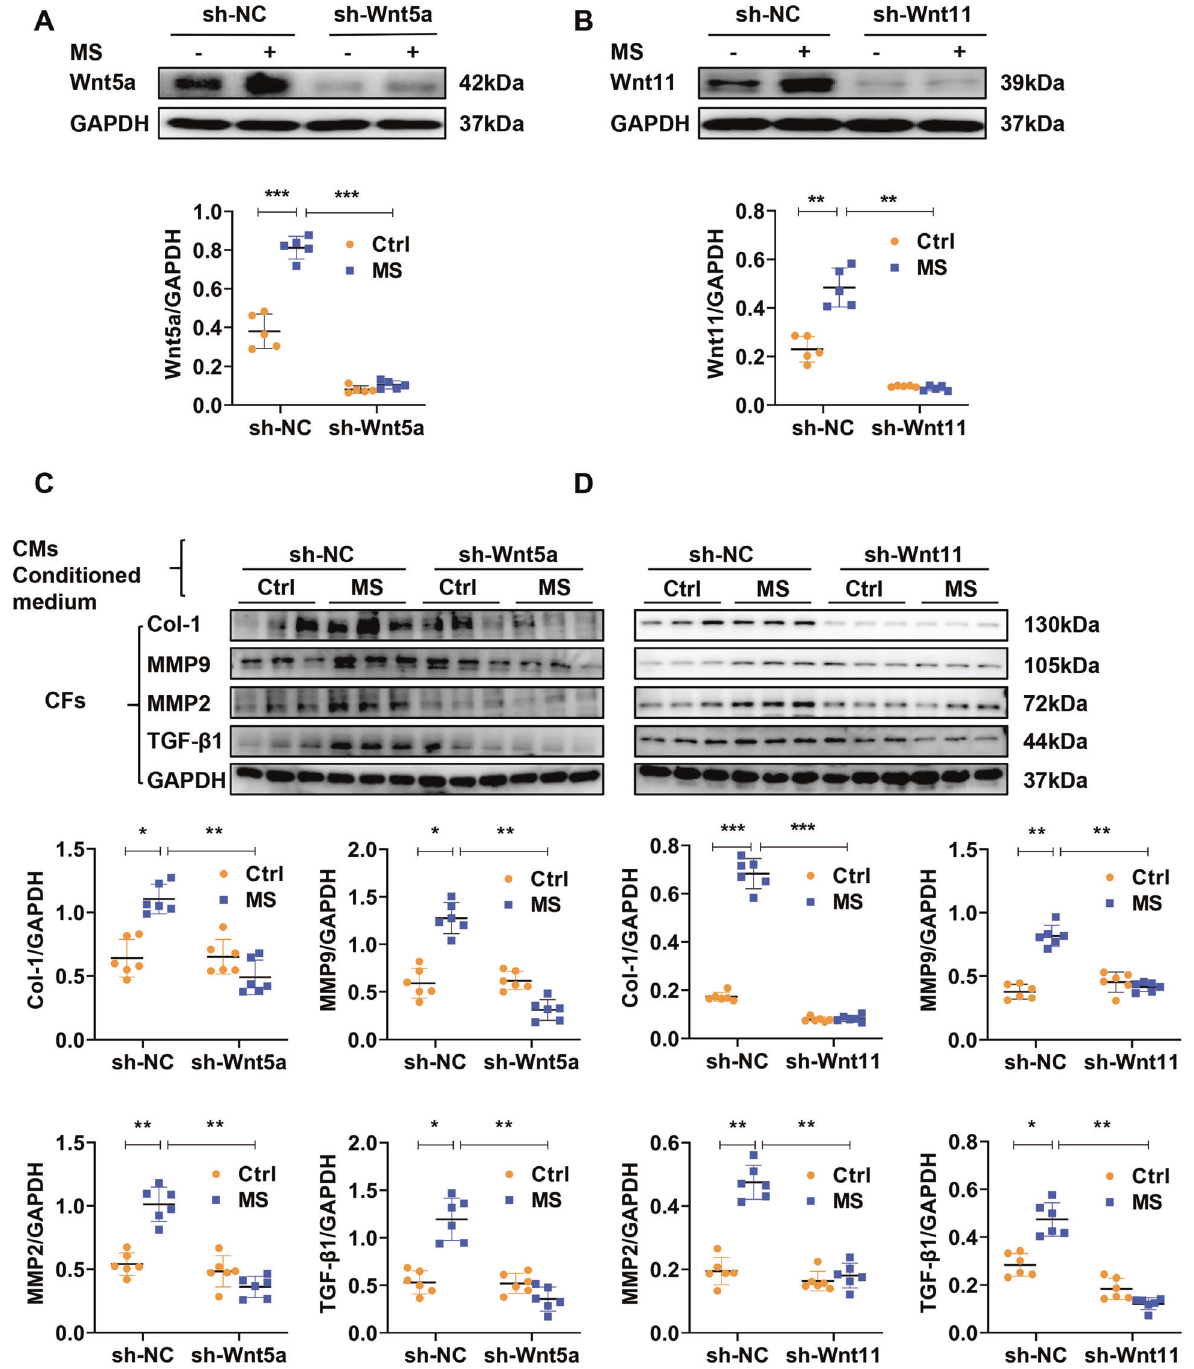
Fig. 4 Cardiomyocyte-secretory Wnt5a or Wnt11 is involved in pro- fi brotic effects under pressure overload. A , B Western analysis of Wnt5a or Wnt11 in stretched (MS) or control (Ctrl) cardiomyocytes pre-transfected sh-Scramble (sh-NC), sh-Wnt5a or sh-Wnt11 lentivirus, respectively. n = 5/group. C , D Western analysis of Col-1, MMP9, MMP2, and TGF- β 1 in cardiac fi broblasts (CFs) treated with conditional medium from cardiomyocytes (CMs) in ( A ) or ( B ), respectively. n = 6/group Stretched (MS) or control (Ctrl) cardiomyocytes were pre- transfected with sh-Scramble (sh-NC), ()shWnt5a or shWnt11 lentivirus, respectively. The conditional medium of these cardiac myocytes was collected to treat fi broblasts for 24 h, and the expressions of Col-1, MMP9, MMP2, and TGF- β 1 were detected by Western blot. All data were shown as mean ± SEM; * P < 0.05, ** P < 0.01, *** P < of p38 and ERK signaling mediated by Wnt5a or Wnt11 in CFs EGFR were knocked down by si-EGFR transfection in CFs (Fig. 7C, D). treated with Wnt5a or Wnt11. Si-EGFR greatly inhibited the fi brotic effects characterized by the decreased expression of Col- FZD5 has been reported to be involved in the signaling induced by Wnt5a [13]. Wnt5a or Wnt11 greatly increased the expression 1, α -SMA, MMP9, MMP2, and TGF- β 1 in CFs with Wnt5a or Wnt11 of FZD5 in CFs, which was signi fi cantly attenuated by si-EGFR or treatment (Fig. 7A, B). Similarly, Si-EGFR inhibited the activation